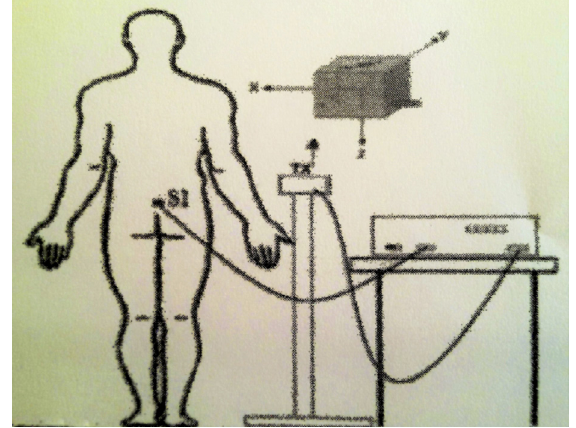
Location of electromagnetic sensors. Tx, transmit- ter and three-plane representation. S1, sacral region. Adapted from Carneiro et al.